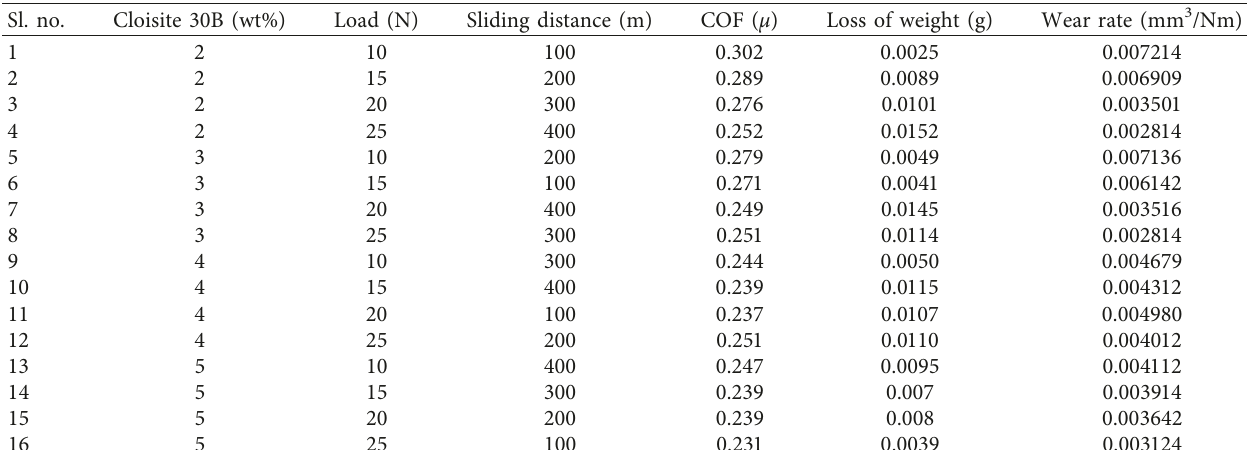
Table 3: Results for COF, loss of weight, and SWR.